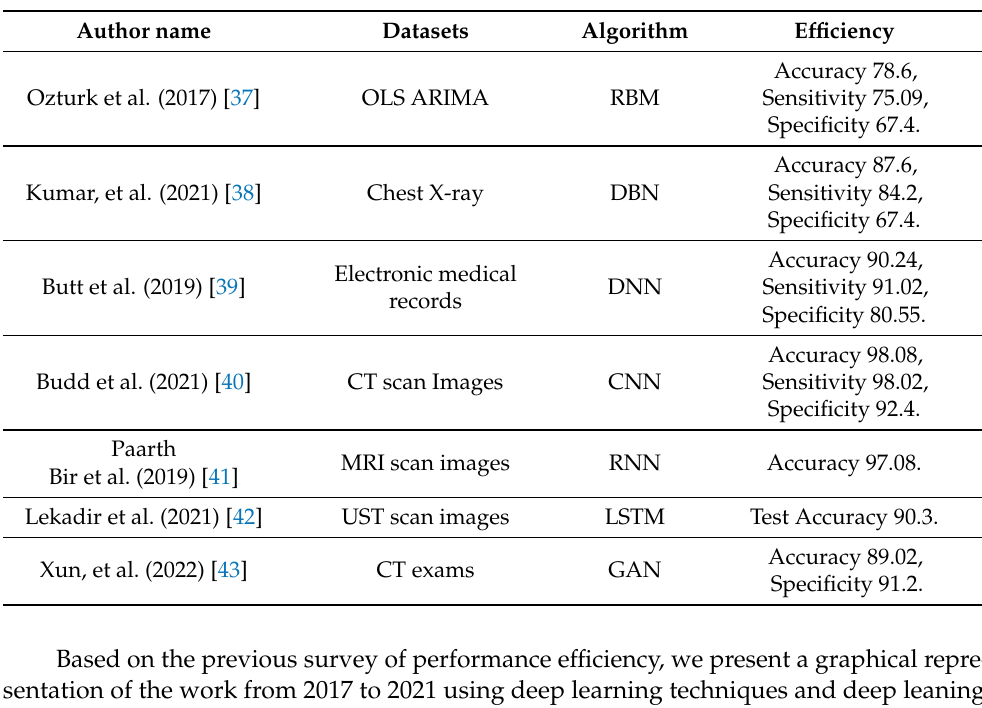
Table 5. Overall performance efficiency.